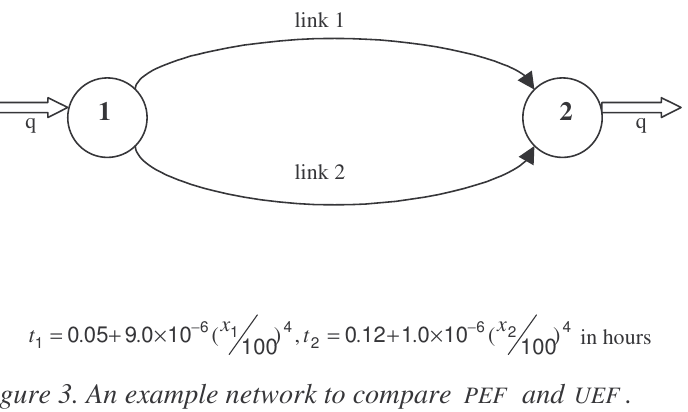
Figure 3. An example network to compare PEF and UEF .